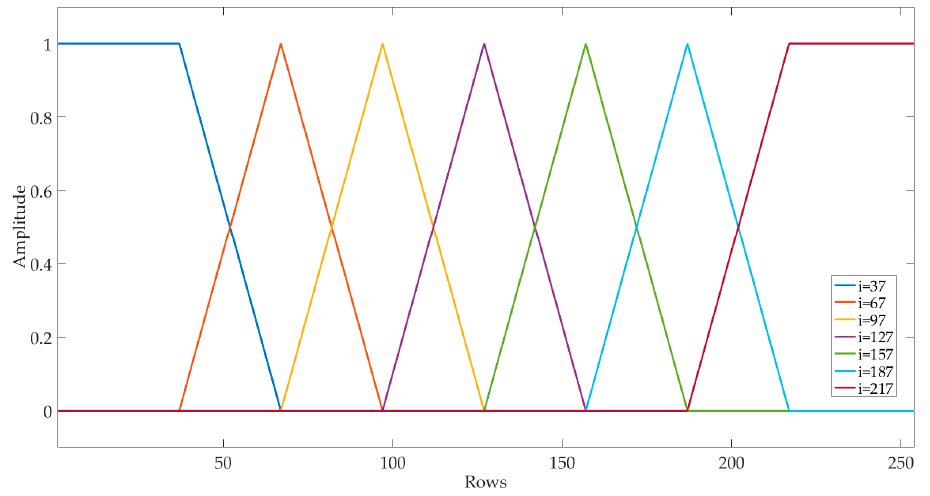
Figure 5. Weighing functions for the 7 PSFs.